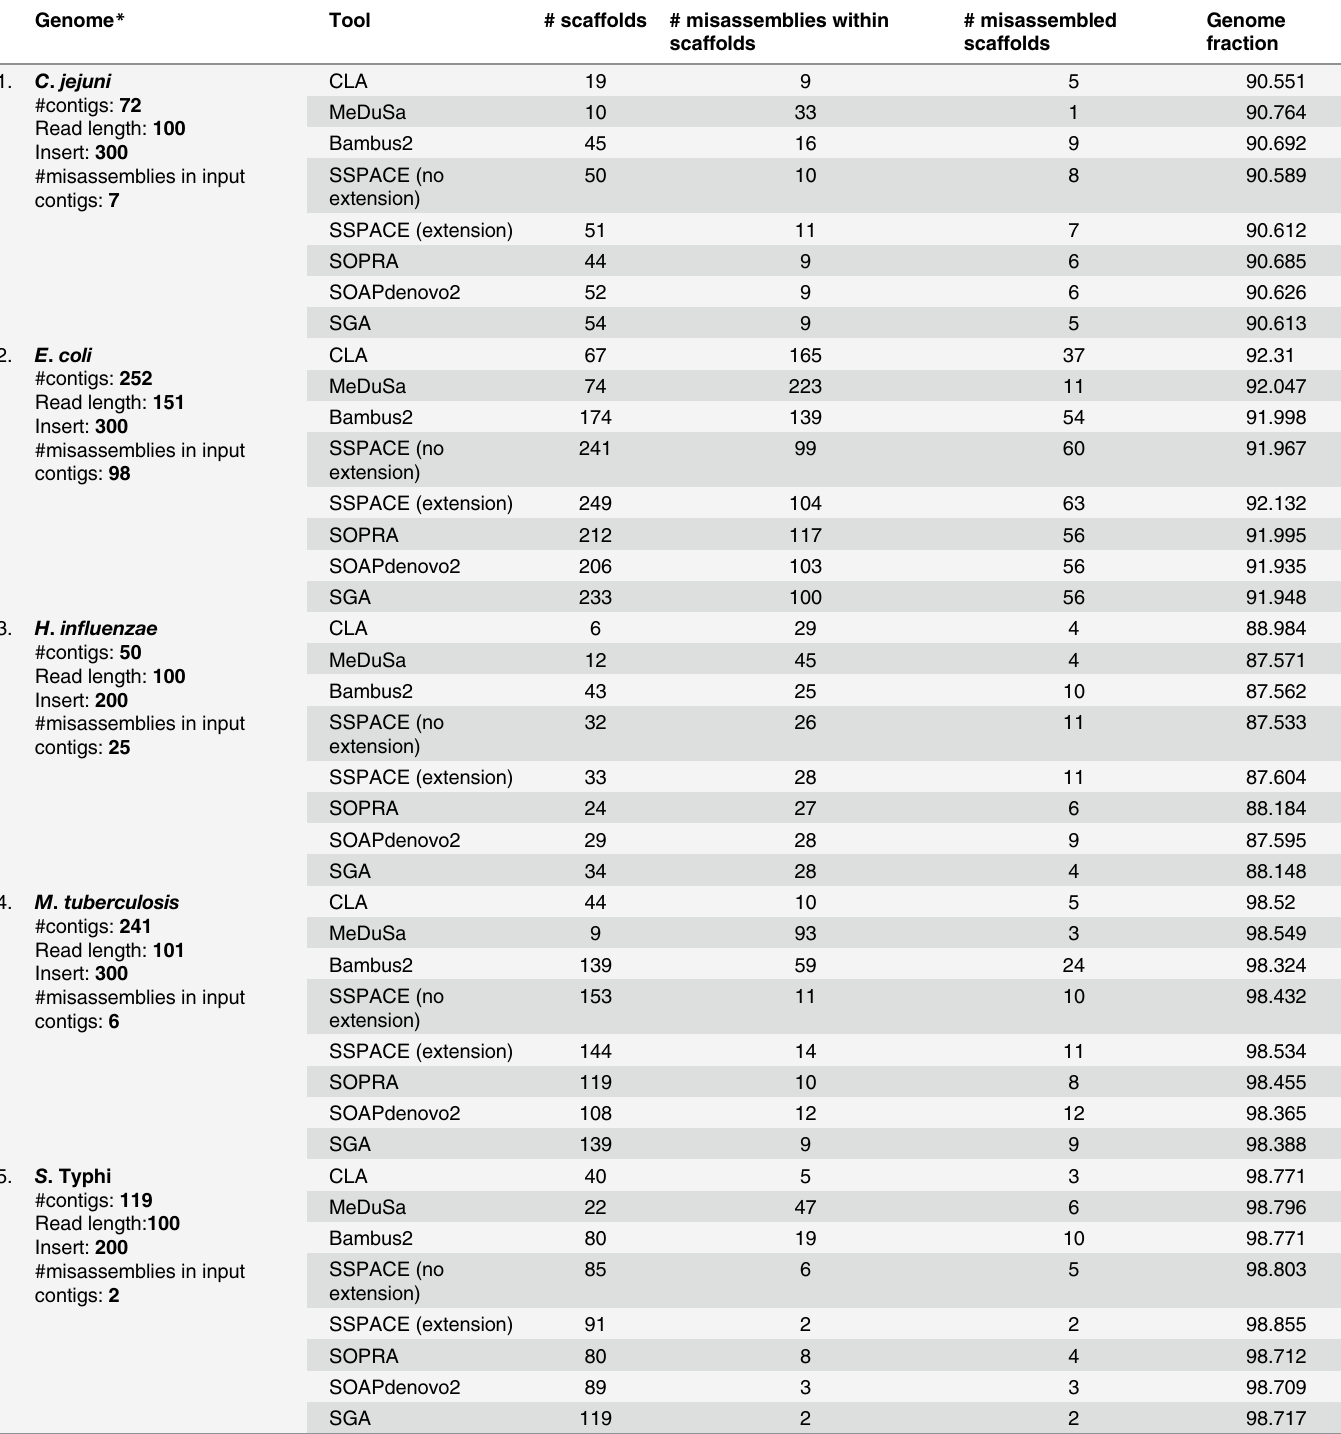
Table 4. Comparative statistics of CLA and Scaffolding tools generated using real dataset. Genome * Tool # scaffolds # misassemblies within